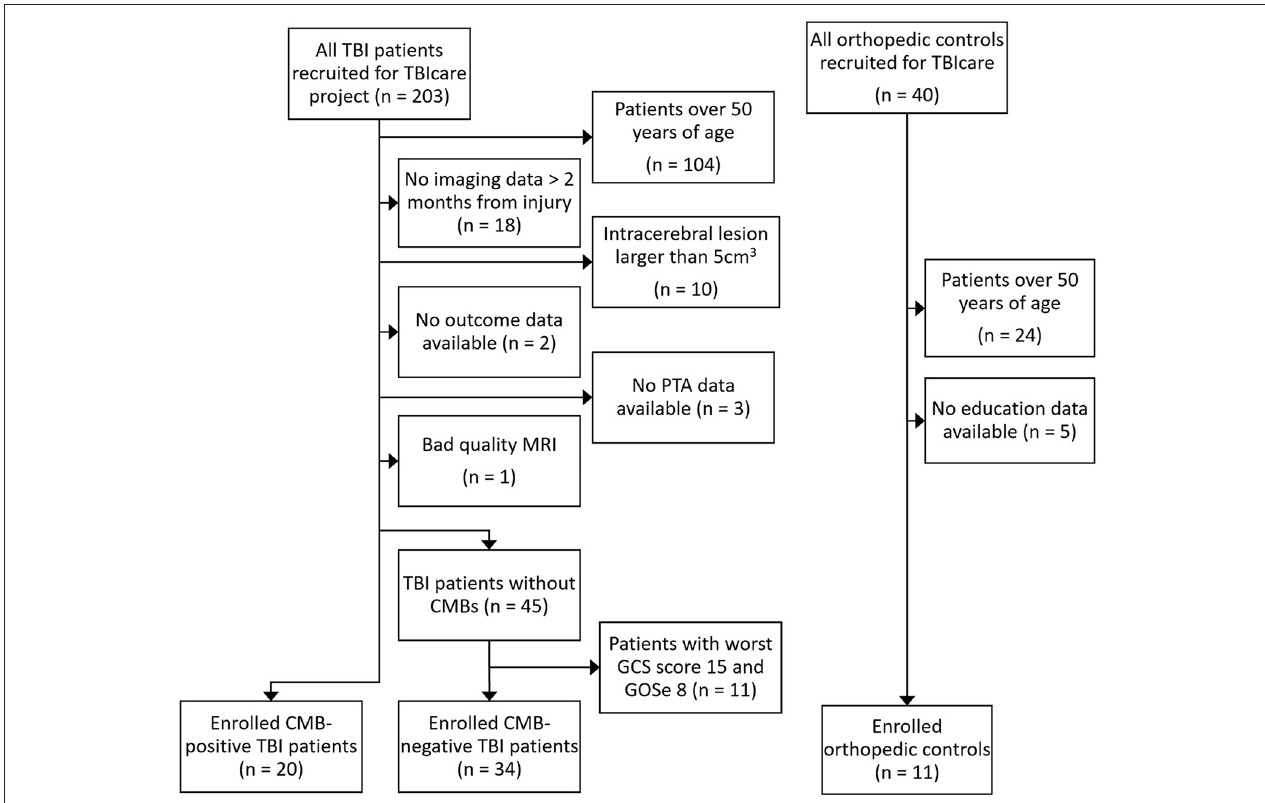
FIGURE 1 | Flowchart of inclusion and exclusion of the study groups. TBIcare, EU-funded international Evidence-based Diagnostic and Treatment Planning Solution for Traumatic Brain Injuries; TBI, traumatic brain injury; PTA, post-traumatic amnesia; MRI, magnetic resonance imaging; CMB, cerebral microbleed, GCS, Glasgow Coma Scale, GOSe, Glasgow Outcome Scale